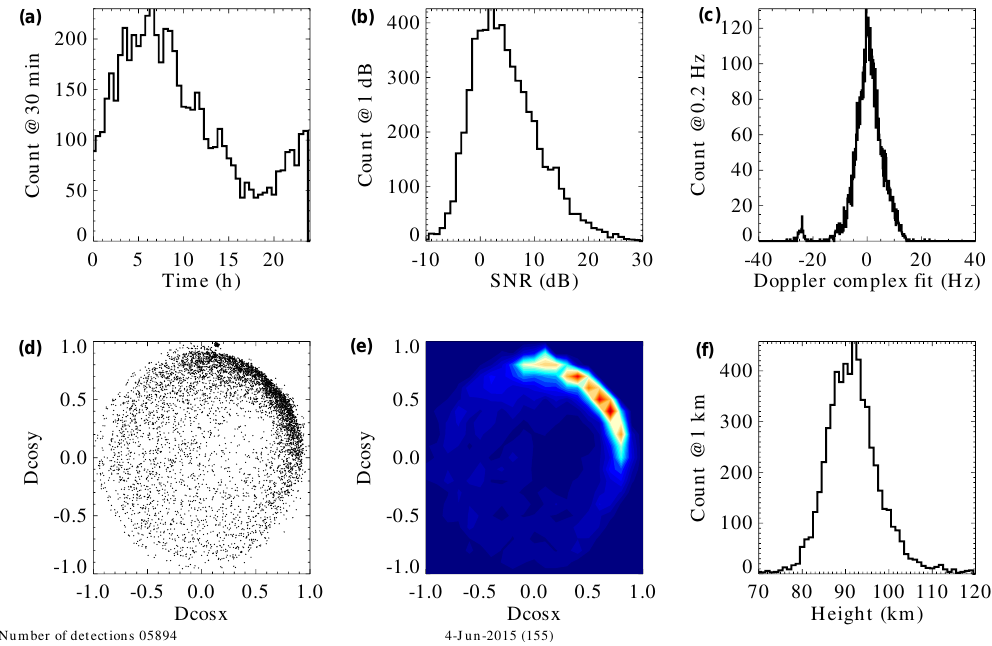
Figure 6. Same as Fig. 5, but with false detections that are considered to be caused by external interference are removed, in addition to echoes that are considered to be from overdense meteor trails.